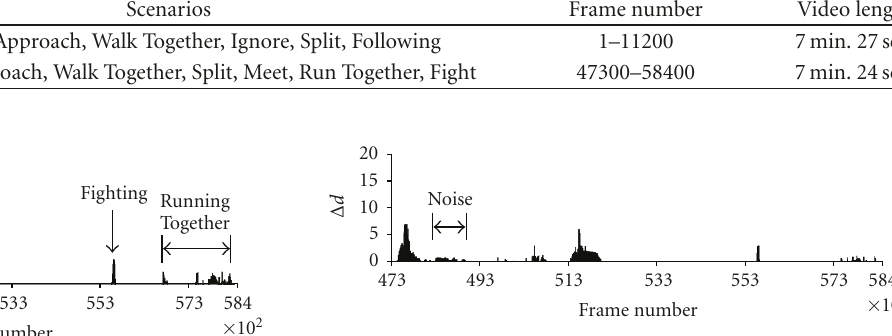
Figure 12: Detection results with the 7 moment-based features f 1 to f 7